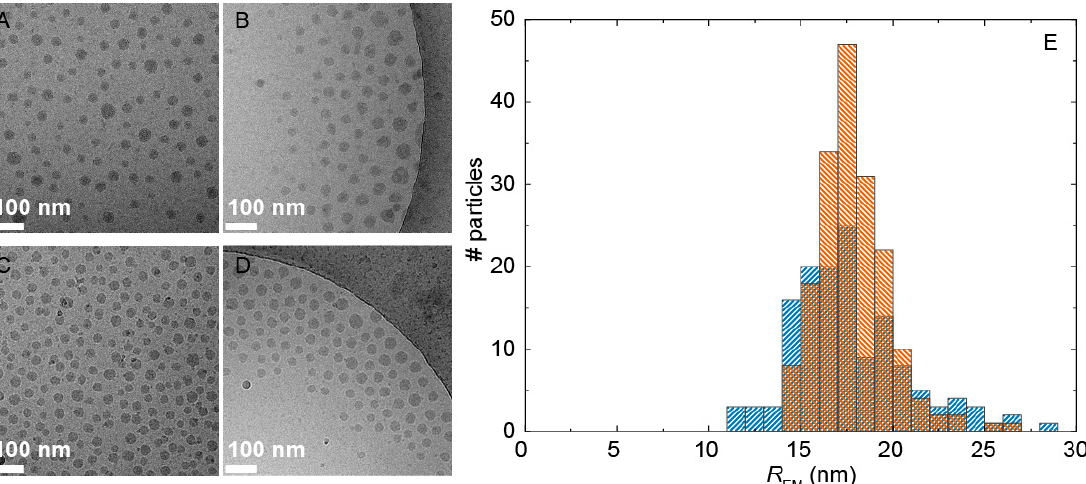
Figure 3. ( A – D ) Representative cryoTEM micrographs of PUI-A2 :PMVP 29 - b -PEO 204 with ( A ) and without ( B ) uranyl acetate staining, and of PUI-S2 :PMVP 29 - b -PEO 204 without staining ( C , D ). ( E ) Size distributions showing the number (#) of particles obtained from image A–D, n = 140 for PUI-A2 :PMVP 29 - b -PEO 204 (blue ///) and n = 180 for PUI-S2 :PMVP 29 - b -PEO 204 (orange \\\).